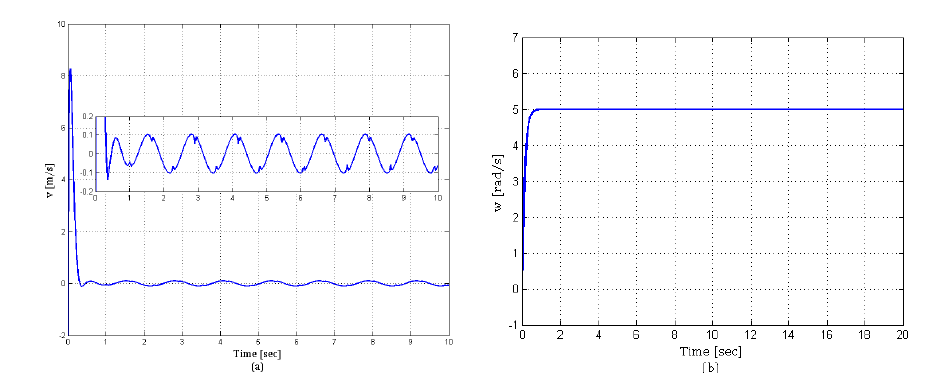
Figure 4. Circular trajectory tracking: ( a ) linear velocity v (m/s) and ( b ) angular velocity ω (rad/s).